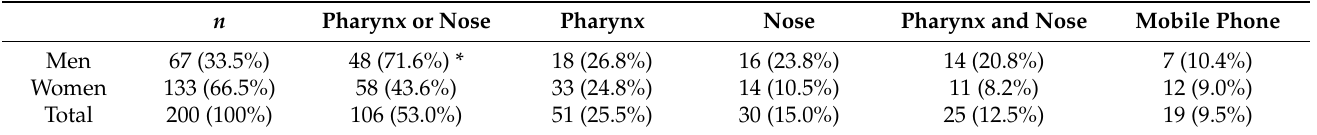
Table 1. Distribution of Staphylococcus aureus strains in the different niches by